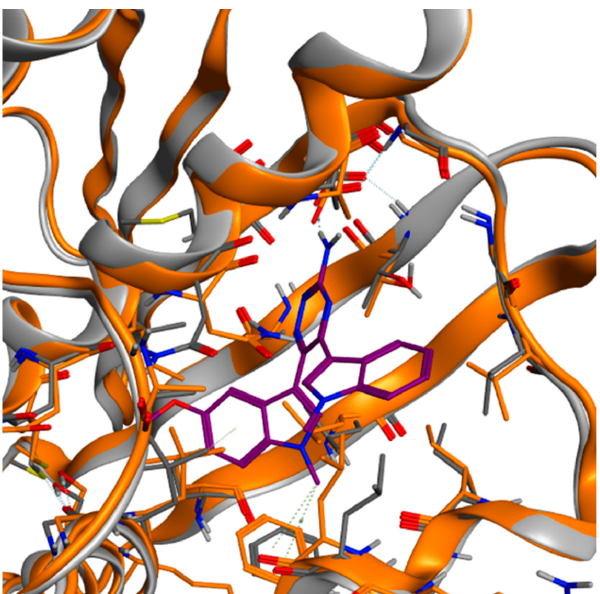
Figure 4. Depiction of the changes in the ATP-binding site resulting from the ligand-based homology model created on the crystallographic structure having PDB code 2Q8F. The potent ligand 6h was kept in the binding pocket during the modeling run. The original crystal is colored orange, while the model obtained is colored grey. The manually placed ligand 6h is colored purple. As can be seen, the small shifts in the lateral chains of some amino acids allow the formation of a larger volume inside the ATP- binding pocket, which has proved to be decisive to the ligand-binding of the molecules under exami- nation. The image was created and rendered with